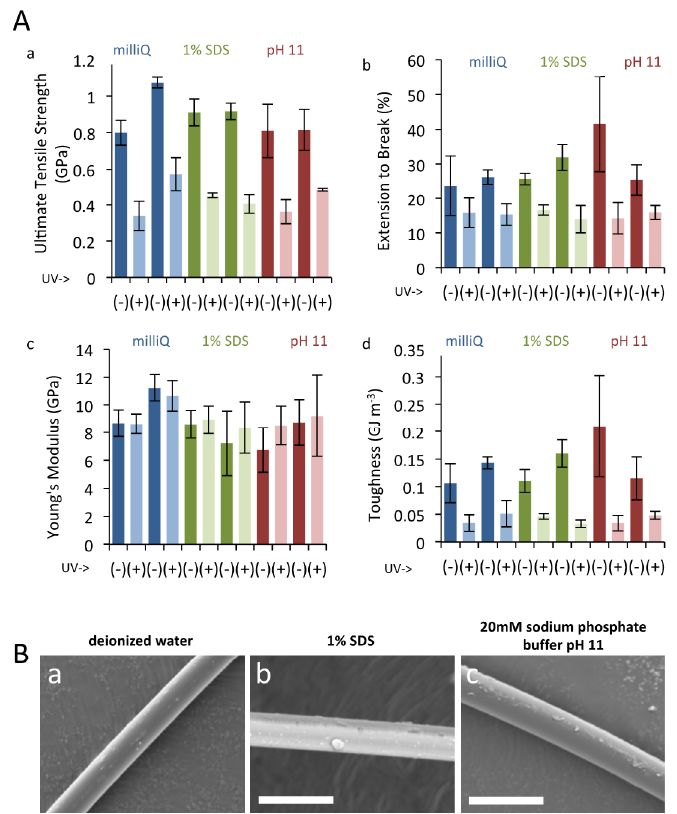
Figure 3. UV irradiation to dragline silk. ( A ). Tensile deformation test results of T. clavata dragline silk. Calculated values for ultimate tensile strength ( a ), elongation to break ( b ), Young’s modulus ( c ), and toughness ( d ) are shown. Results for two individual replicates are presented for each of the three pigment extraction treatments (control, 1 % SDS, and pH 11), with and without subsequent UV irradiation. Error bars represent standard deviation values for three separate experiments. ( B ). SEM results for T. clavata dragline silk treated with ( a ) deionized water, ( b ) 1 % SDS, and ( c ) 20 mM sodium phosphate buffer pH 11. Scale bars represent 10 µm.